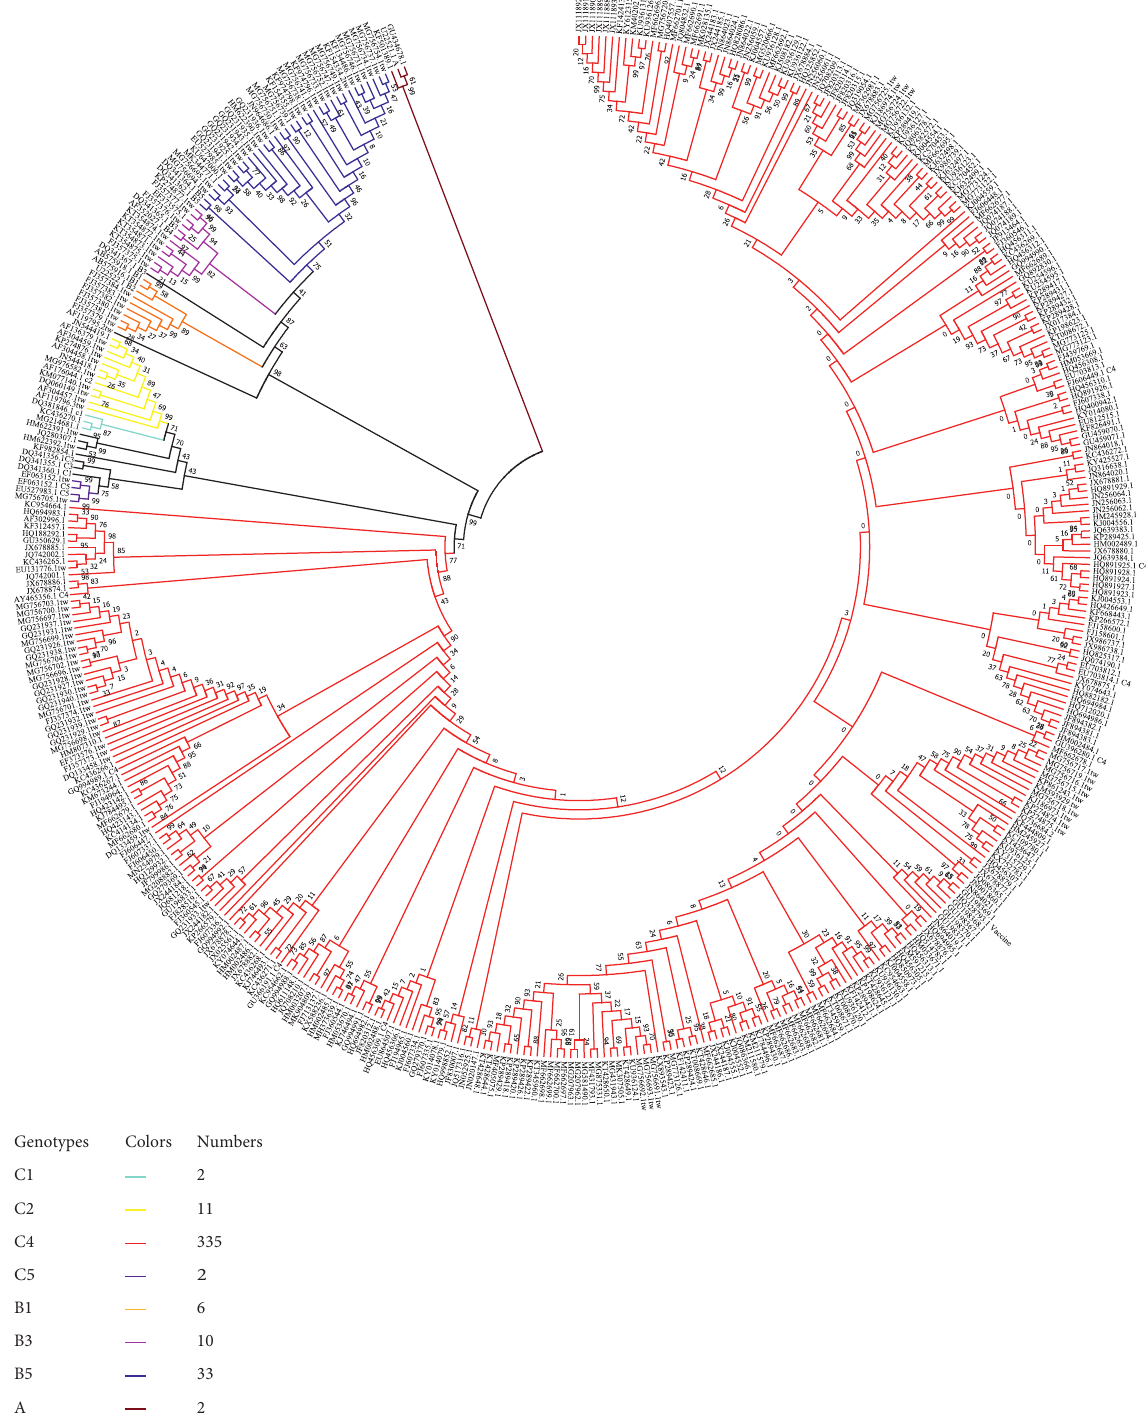
Figure 3: Phylogenetic tree constructed with the VP1 nucleotide sequences (891bp) of EV-A71 strains with the complete genome. Red branches indicate genotype C4 strains; blue branches indicate genotype B5 strains; orange branches indicate genotype B1 strains; light blue branches indicate genotype C1 strains; yellow branches indicate genotype C2 strains; pink branches indicate genotype B4 strains; brown branches indicate genotype A strains; purple branches indicate genotype C5 strains. Each strain was named according to the GenBank accession number. Taiwan’s strains have a TW suffix, reference strains have corresponding subtype name suffixes, and vaccine strains have the vaccine